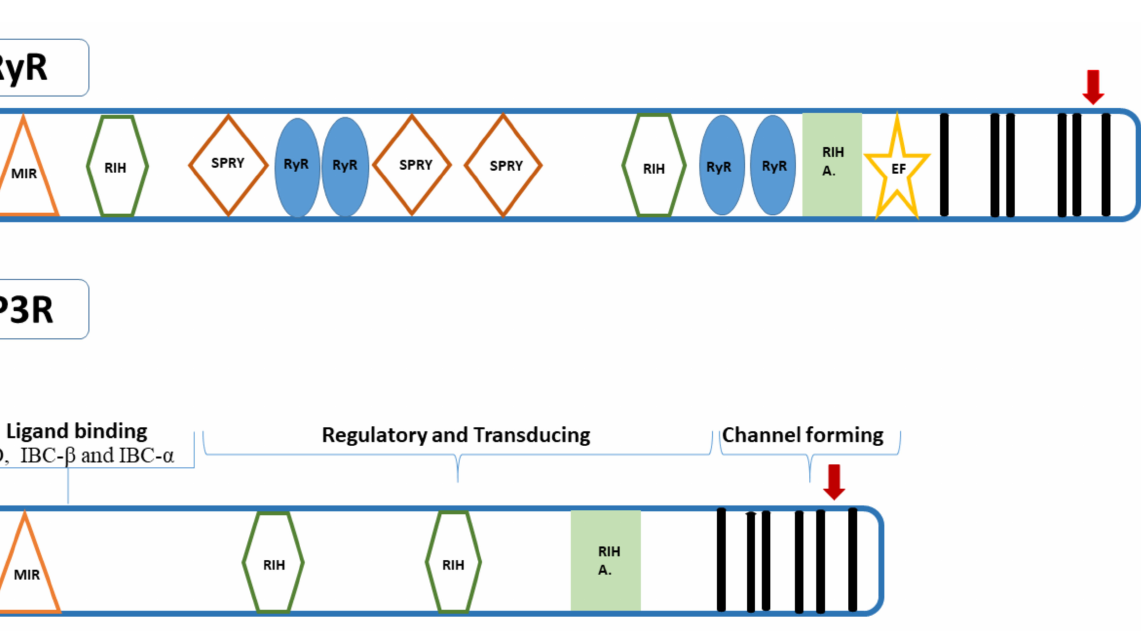
Figure 1. The conserved domains for RyR are listed as following MIR (Mannosyltransferase, IP 3 R, and RyR, pfam02815), RIH (RyR and IP 3 R Homology, pfam01365), the SPRY (spIA and RyR domains, pfam00622), RyR domain (pfam02026) [71,90–92], RIH A domains (RIH-associated, pfam08454) [89], EF-hands, and putative transmembrane domain (TM1-TM6). IP 3 R has three putative functional regions: ligand binding, central regulatory, and channel forming sites. Ligand binding region includes three subdomains, the IP 3 -binding core β (IBC- β ) and α (IBC- α ) that interact with IP 3 ; and the suppressor domain (SD) reducing the affinity for IP 3 [81–85]. The conserved domains for IP 3 R are listed as following MIR RIH, RIH A, and TM1-TM6. Arrow corresponding to TM5 and TM6 including the suppressor domain and ligand binding, which leads to modulation of the gating of the Ca 2+ pore in both